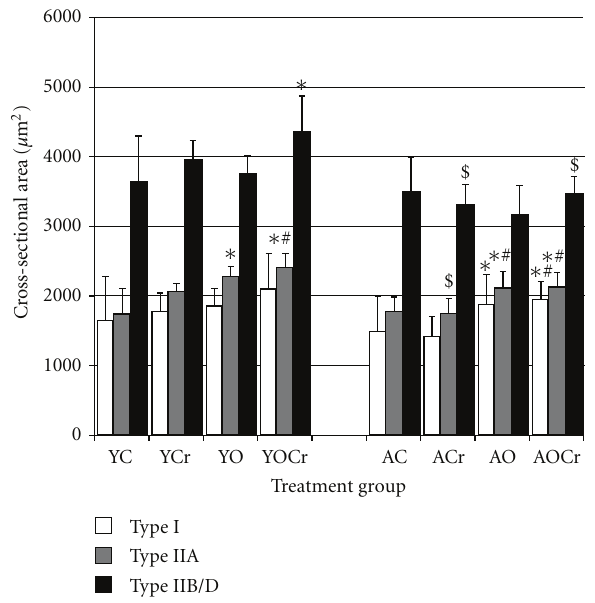
Figure 2: Cross-sectional area for plantaris muscle in young and aging animals for all treatment groups. Open bars are type I fibers, grey bars are type IIA fibers, and closed bars are IID/B fibers. Data are presented as mean ± SD. ∗ Significantly di ff erent than control treatment, within age group ( P < 0 . 05); # significantly di ff erent than creatine group, within age group ( P < 0 . 05); $ significantly di ff erent than same treatment in young rats ( P < 0 . 05).